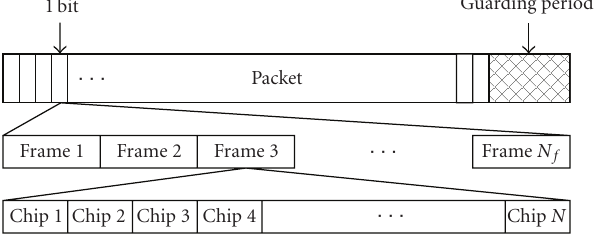
Figure 3: Signal